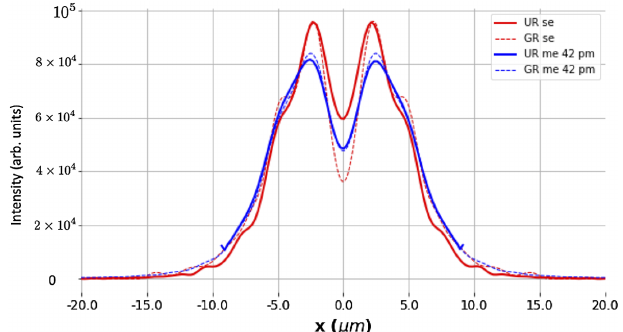
FIG. 11. Spatial projections of Gaussian and undulator radia- tion propagated through single slit aperture and 10 cm drift via WFD method. In the legend, se denotes single electron (fully coherent) and me denotes multi-electron (partially coherent). For the latter, the photon beam has been convolved with the APS-U electron beam given in Table